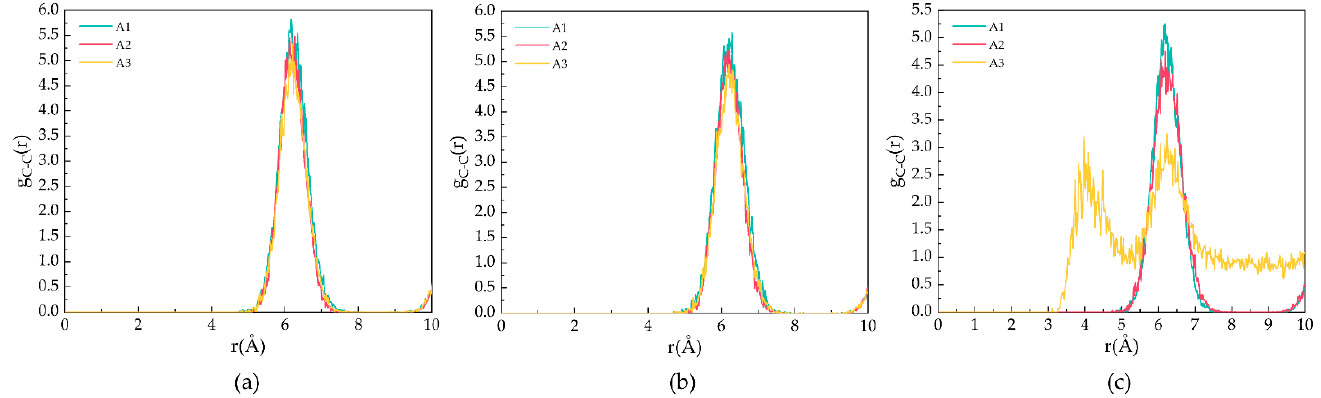
Figure 4. RDFs of carbon atoms in CH 4 molecules of A1, A2, and A3 model after 500 ps at P = 2 MPa and three different temperatures for ( a ) T = 273 K, ( b ) T = 283 K, and ( c ) T = 293